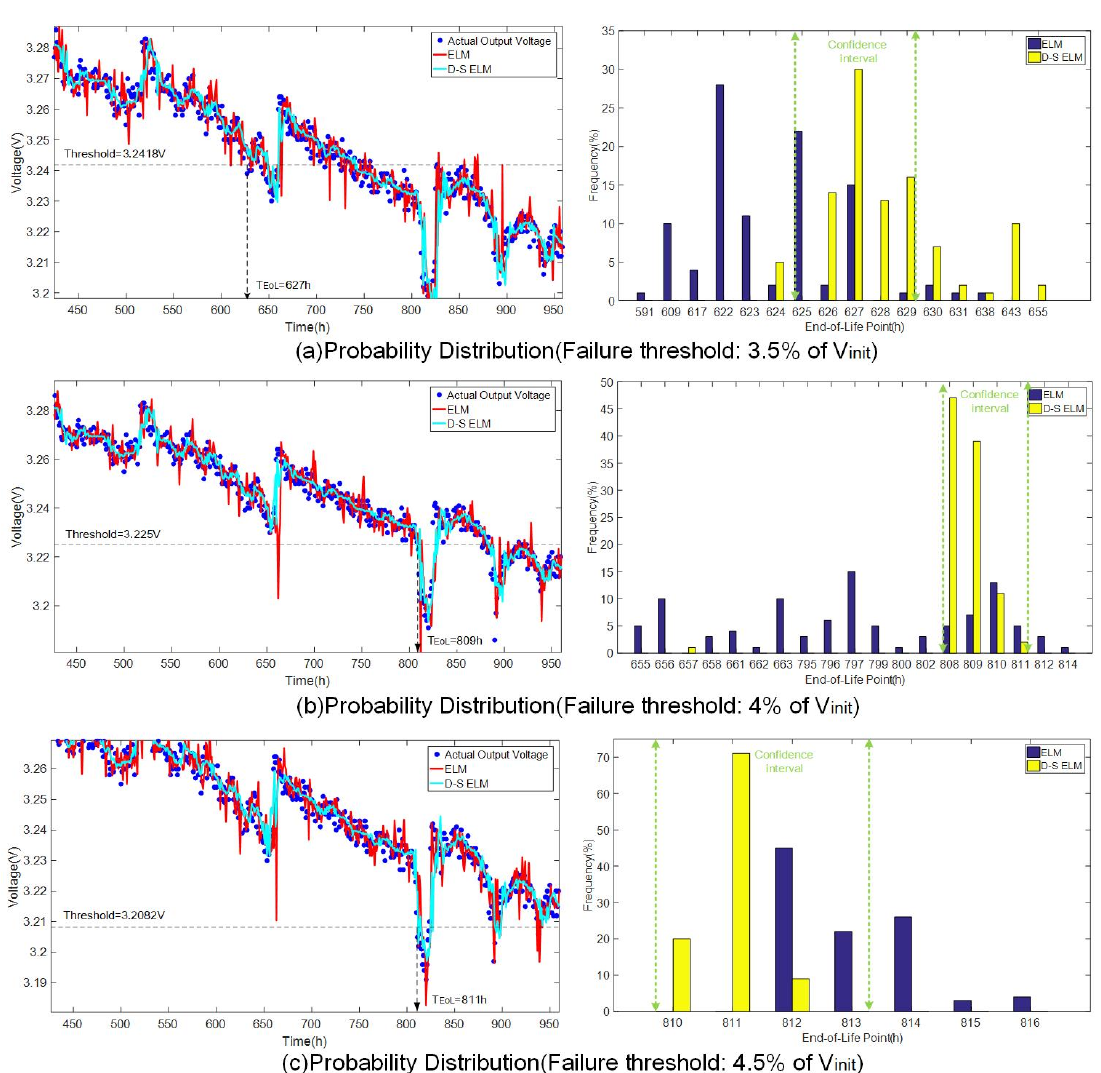
Figure 8. Probability distribution of end-of-life point (the size of training sample is set as 10).